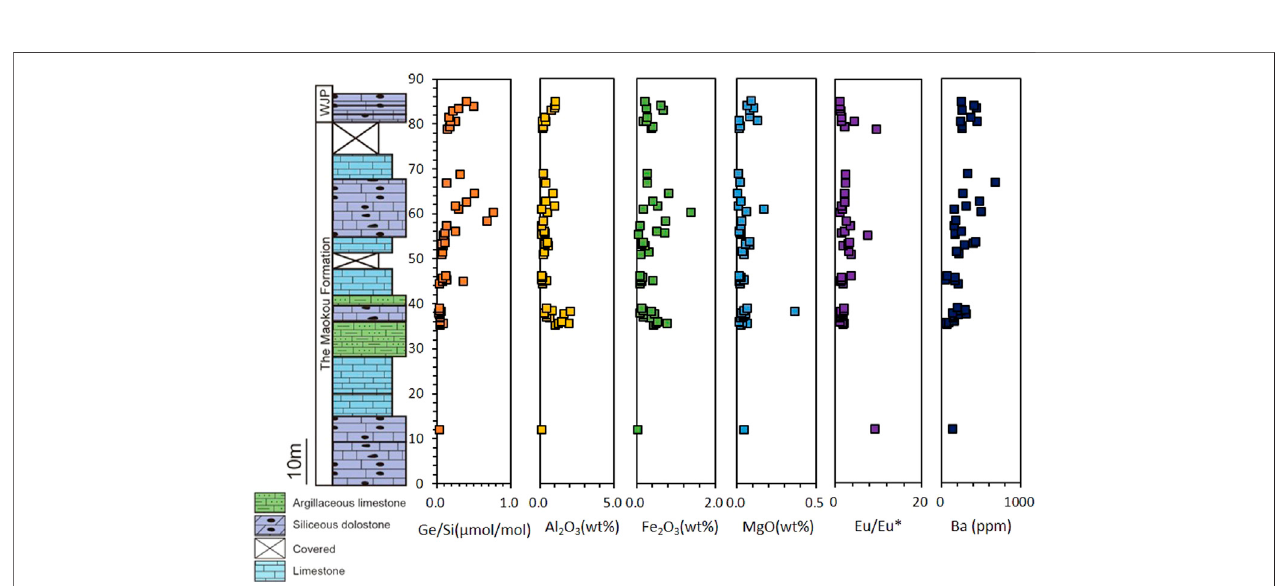
FIGURE 3 | Integrated chemostratigraphy of the Maokou and Wujiaping formations in the Maoertang section.